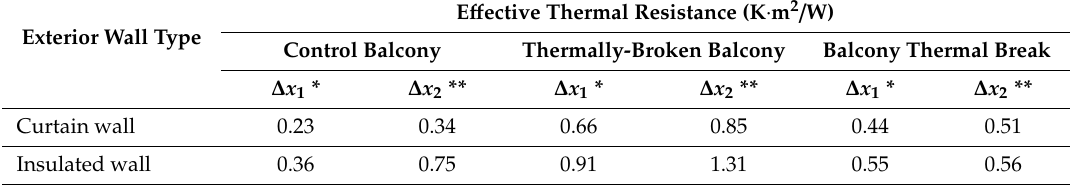
Table 4. Floor slab thermal properties calculated in THERM with two assumed wall types (CM10 thermal break